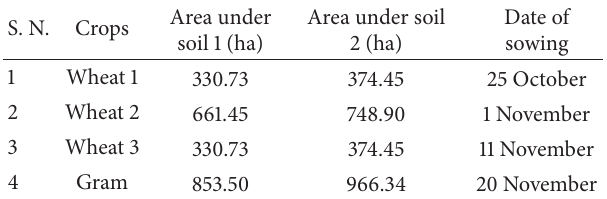
Table 2: Different scenarios generated for irrigation water manage- ment.